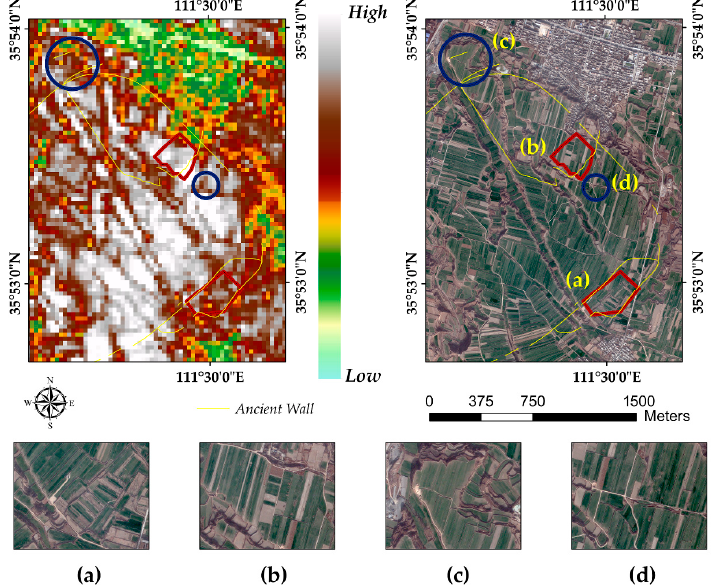
Figure 8. The distribution of negative crop anomalies and main archeological features of Taosi. ( left ) Landsat NDVI of 9 May 2001 and ( right ) Geoeye image of 2 December 2010. Google Earth image 30 August 2013: ( a ) southern sacrificial area and the ancient astronomical observatory, 2003–2005; ( b ) palace area, 2002–2007; ( c ) northern sacrifice area outside the walled site with northern wall, 2000–2004; ( d ) regions of dense cellar holes, 2001. The features have since been refilled after an excavation project.